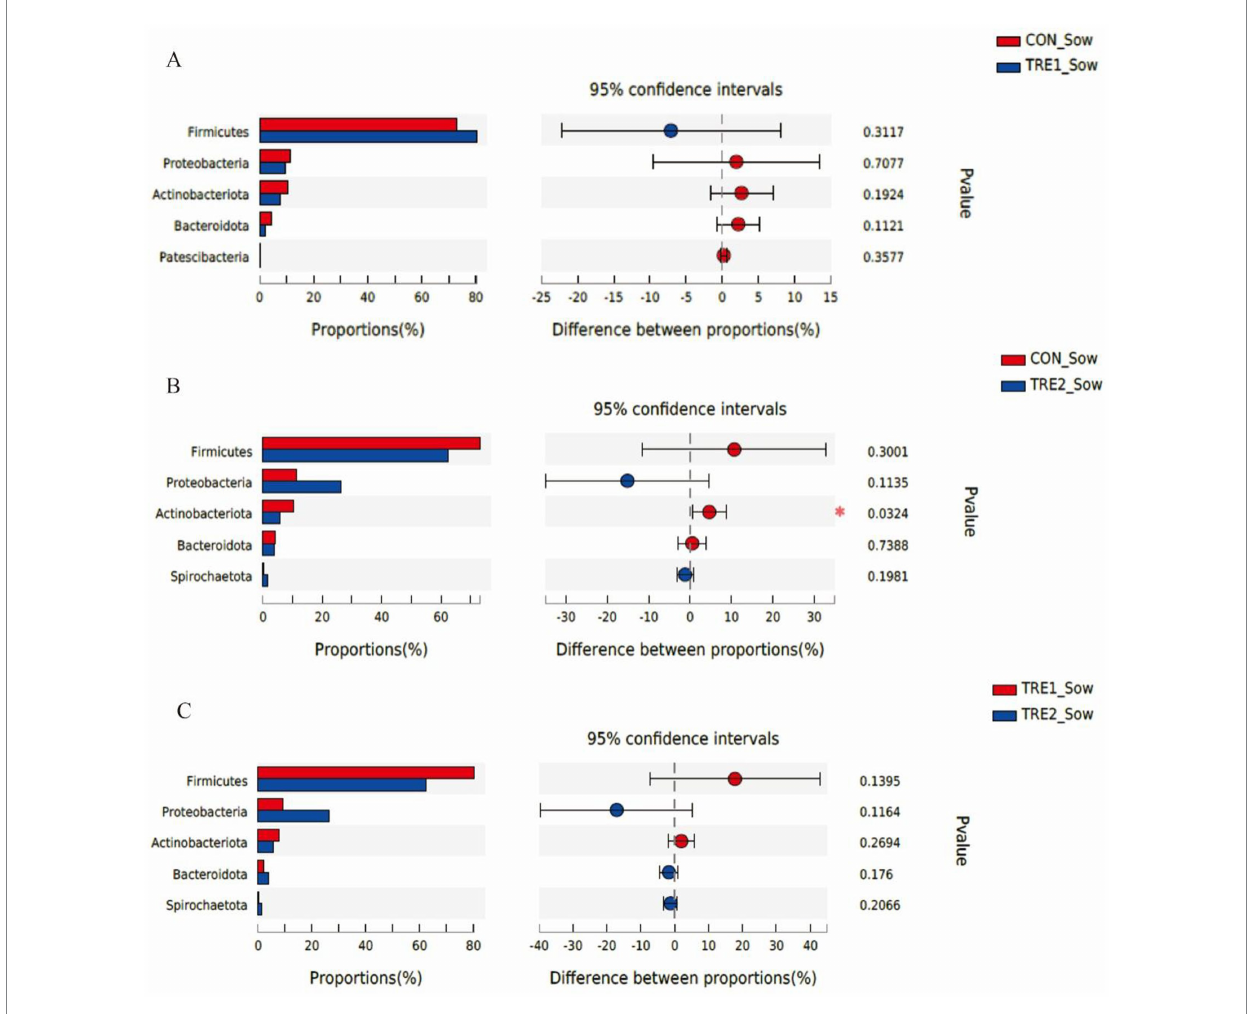
FIGURE 5 Differences in fecal microbiota of sows at phylum level among different groups. (A) The difference of fecal microbiota for sows between the control group and TRE1 group. (B) The difference of fecal microbiota for sows between the control group and TRE2 group. (C) The difference of fecal microbiota for sows between TRE1 and TRE2 groups. Sows are regarded as the experimental units, N = 5 for each